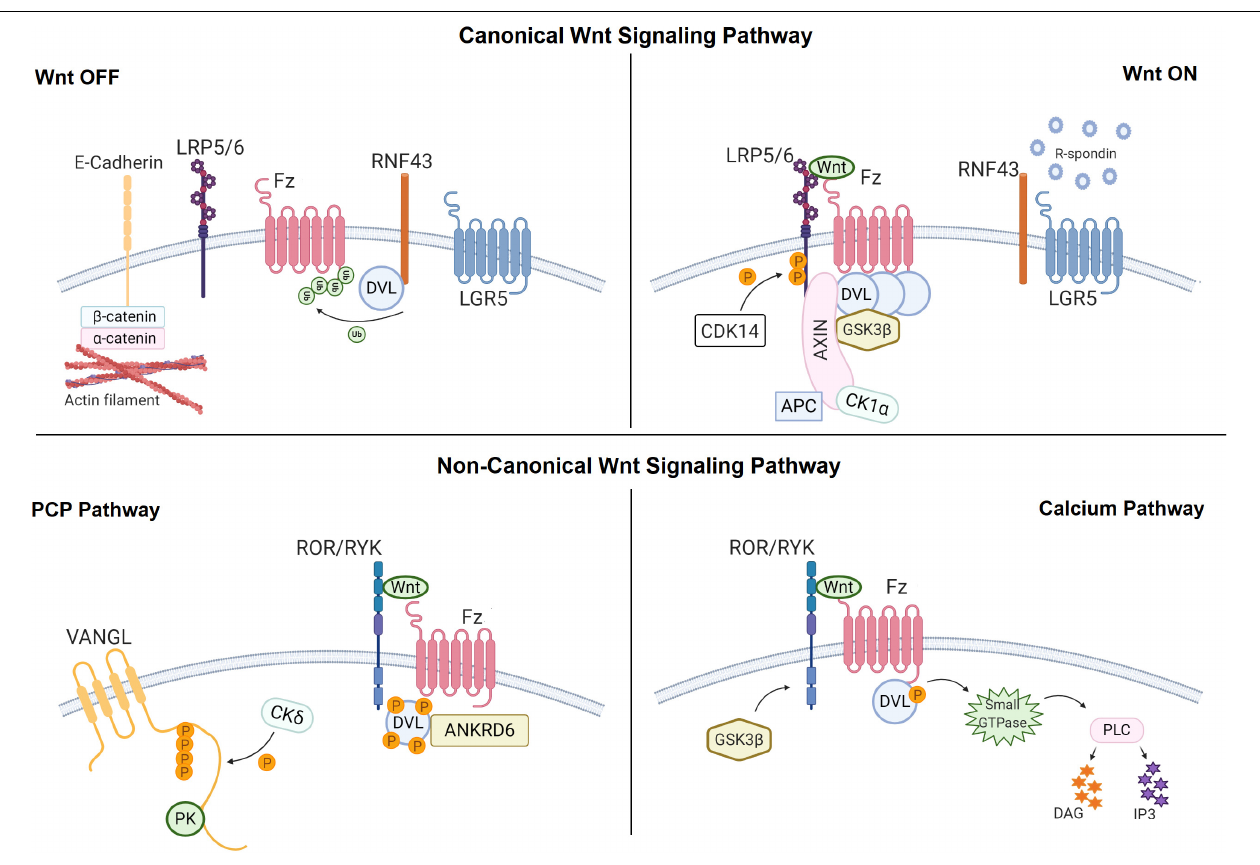
FIGURE 2 | The Wnt signaling pathways at the plasma membrane. Canonical Wnt signaling pathway: In the Wnt OFF state, defined by the absence of canonical Wnt ligand, β -catenin is phosphorylated by the destruction complex that is comprised of glycogen synthase kinase 3 β (GSK3 β ) and casein kinase 1 α (CK1 α ), Axin and dishevelled (DVL) and Adenomatous Polyposis Coli (APC). Ring finger protein 43 (RNF43) also inhibits the pathway by binding the Fz receptor via DVL. In the Wnt ON state, canonical Wnt ligand binds to the Frizzled (Fz) receptor and the low-density lipoprotein receptor-related protein 5/6 (LRP5/6) co-receptor.